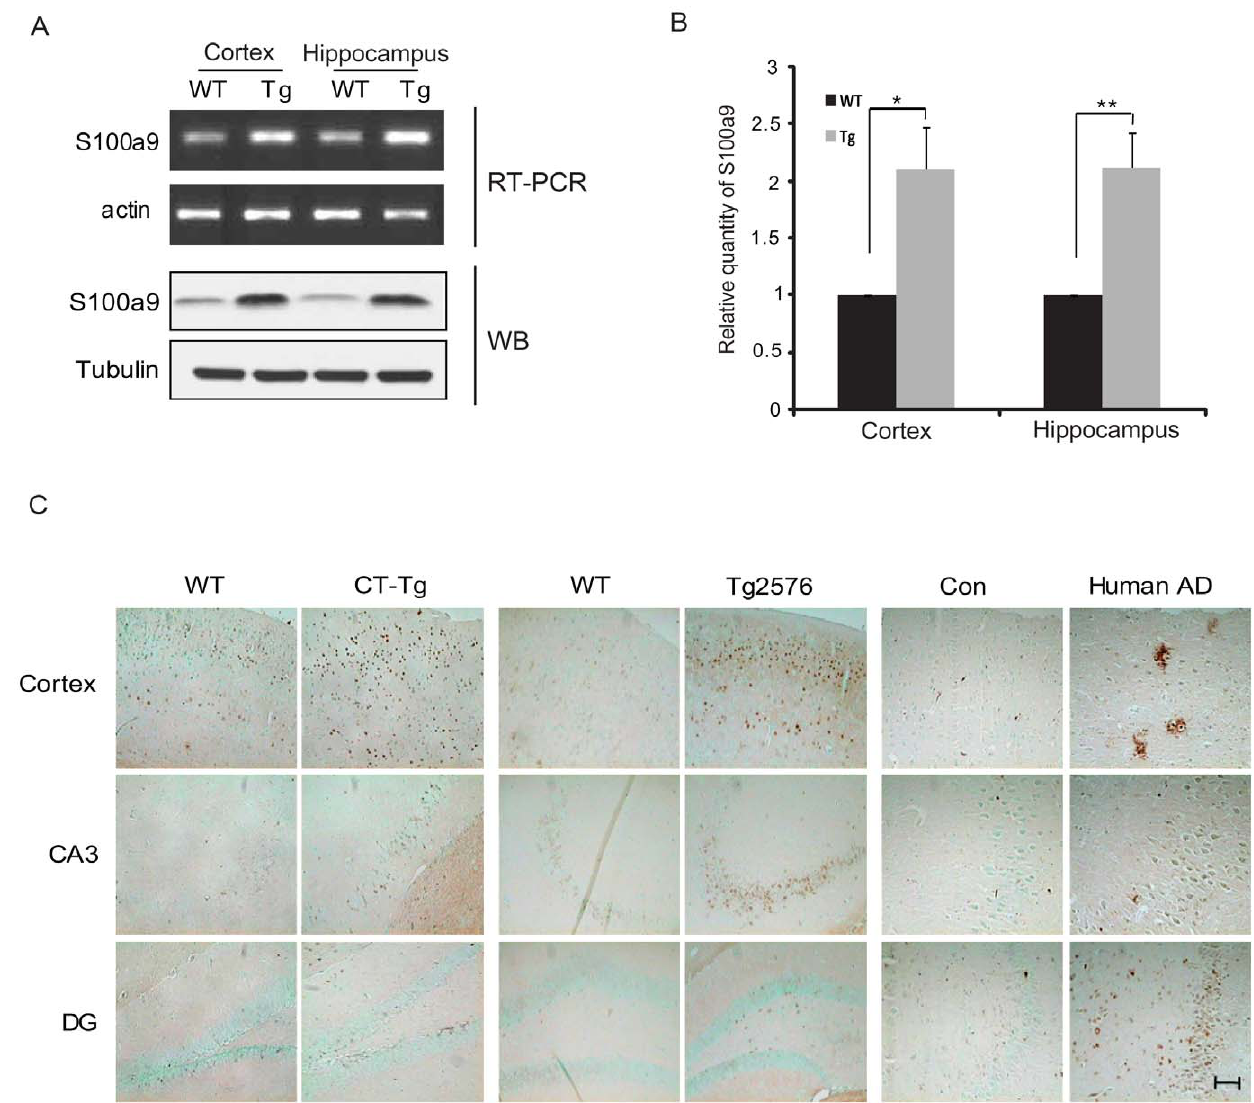
Figure 1. S100a9 was induced in the brains of CT-Tg, Tg2576 mice and Human AD patients. (A) mRNA levels of S100a9 were measured in the cortex and hippocampus of CT-Tg and age-matched WT mice brains by RT-PCR. Actin was used as a loading control. The protein level of S100a9 was checked by western blotting. Tubulin was used as a loading control. (B) S100a9 expression was normalized with that of tubulin for quantification (n=5). Results are presented as the means 6 SEM. *P , 0.05, **P , 0.01 by Student’s t- test. (C) Immunoreactivities of S100a9 were examined in the cortex, hippocampus [CA3, dentate gyrus (DG)] of 11-month-old CT-Tg, of 11-month-old Tg2576 and of human AD brains compared with normal age- matched brains. Scale bar represents 100 m